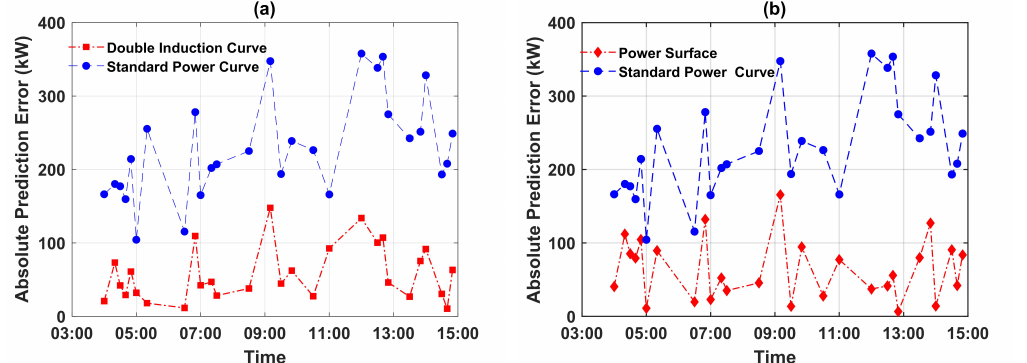
Figure 16. Time series of error reduction in power prediction during a sample twelve-hour period on 16 February 2018 from 3:00 a.m. to 3:00 p.m., resulting from ( a ) double induction curve, and ( b ) power surface, compared to the standard power